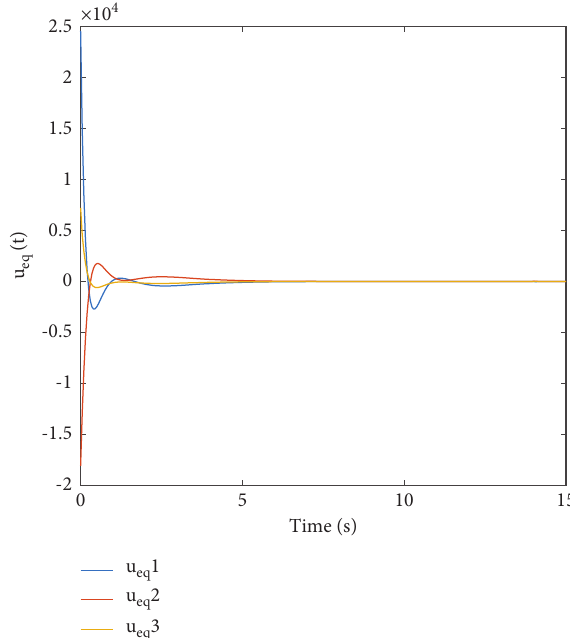
Figure 4: Equivalent control of the sliding mode-controlled power system.